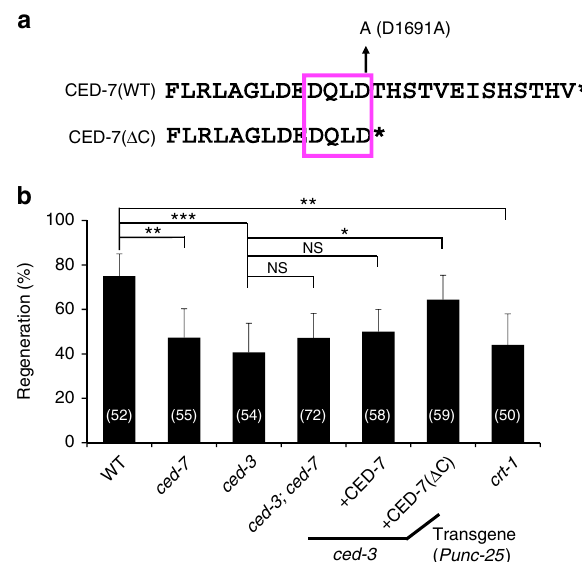
Fig. 6 Caspase CED-3 acts upstream of CED-7 in axon regeneration. a Caspase recognition sequence of CED-7. The CED-3 recognition sequence, DQXD, in its C-terminal region is boxed with a magenta line. b Percentages of axons that initiated regeneration 24 h after laser surgery in the L4 stage. The number ( n ) of axons examined are shown. Error bars indicate 95% CI. * P < 0.05, ** P < 0.01, and *** P < 0.001 as determined by